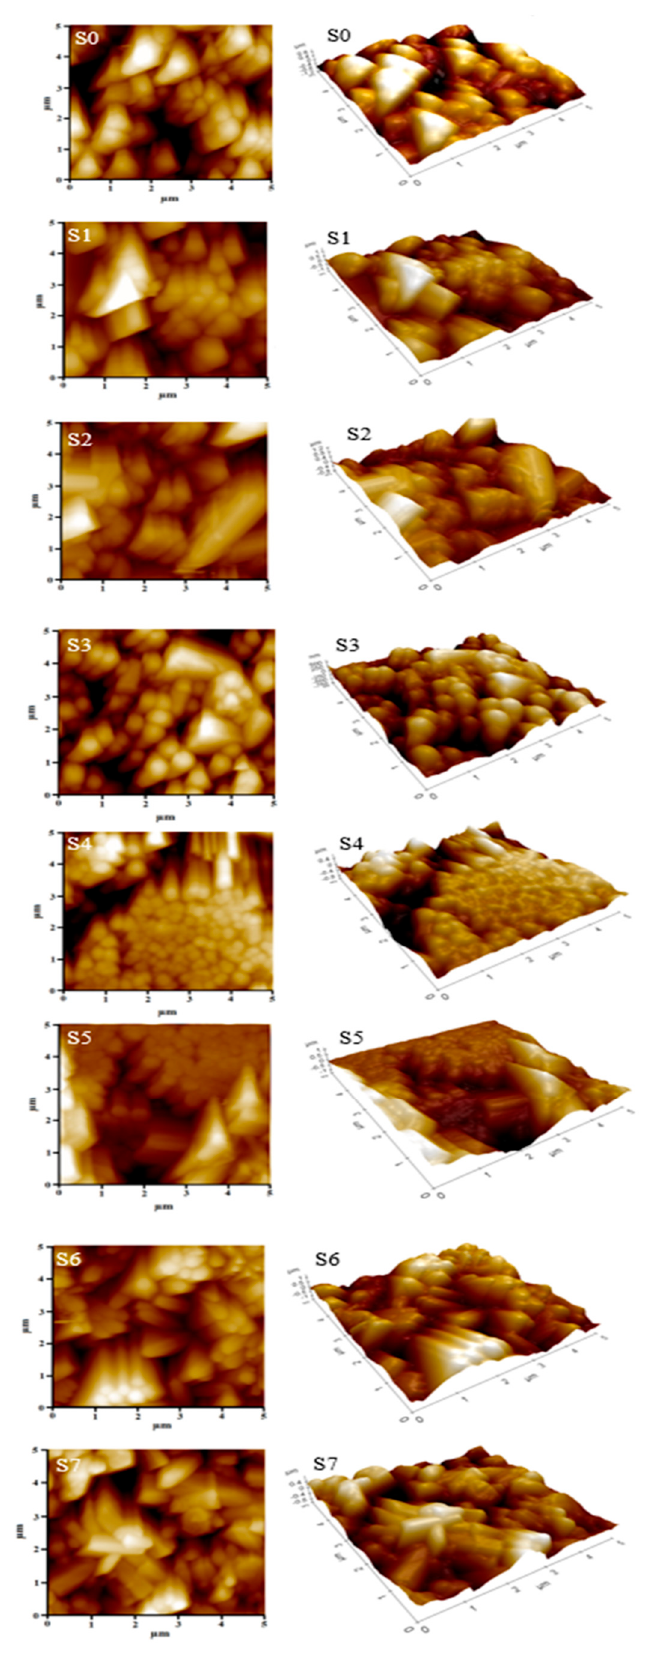
Figure 7. AFM images of the pure and B doped ZnO films. Right column shows three-dimensional AFM images and left column shows two-dimensional AFM images.